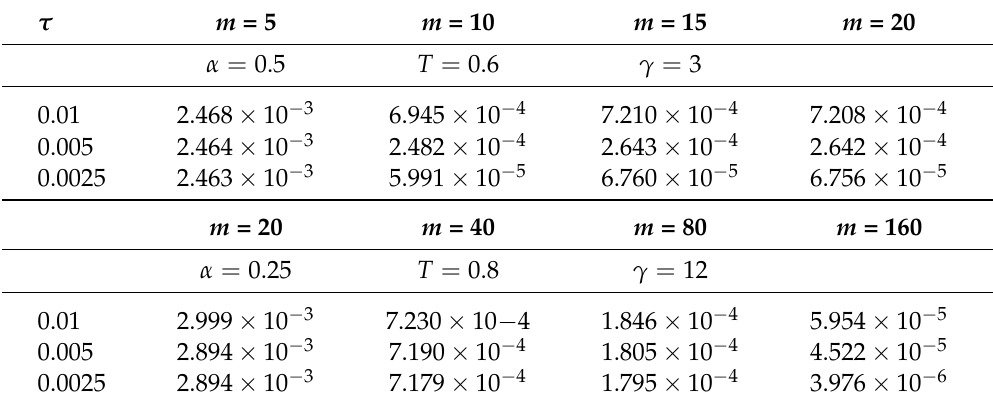
Table 2. The extension method: errors e C ( N , J ) of the solution of the discrete scheme (16) for α = 0.5,0.25 and a sequence of parameters m .